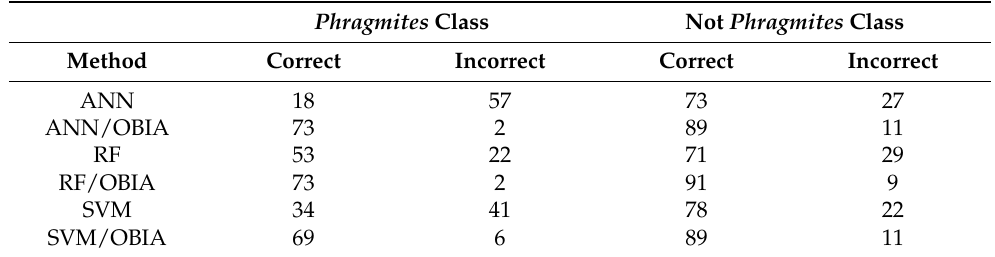
Table 22. Validation assessment points for Grassy Point Park for each of the classification methods.